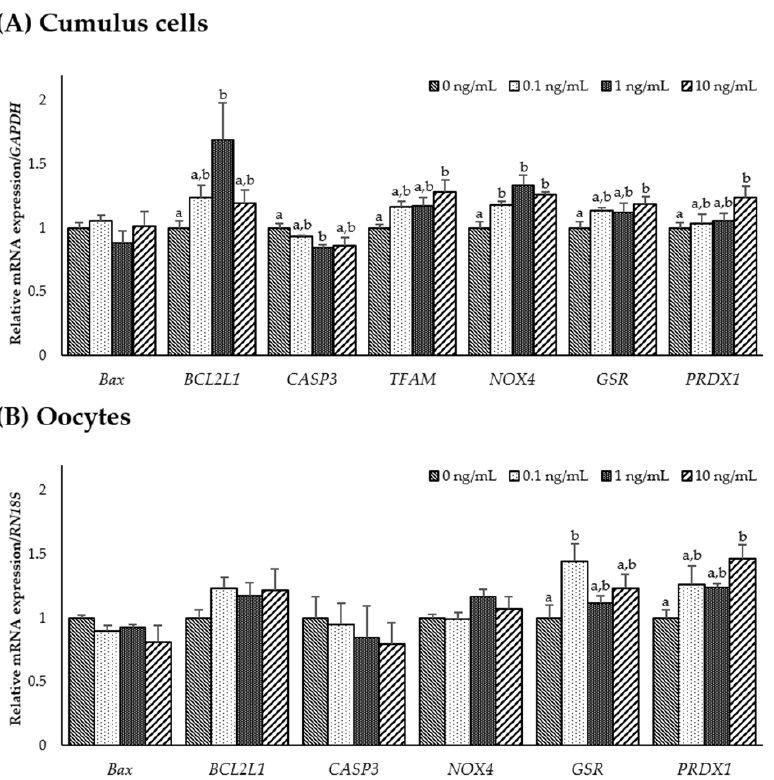
Figure 2. The mRNA expression levels (mean ± SEM) of apoptosis-, mitochondrial-, and antioxi- dant-related genes. Levels of Bax , BCL2L1 , CASP3 , TFAM , NOX4 , GSR1 , and PRDX1 assessed in groups of cumulus cells ( A ) and levels of Bax , BCL2L1 , CASP3 , NOX4 , GSR1 , and PRDX1 assessed in groups of oocytes ( B ) supplemented with various concentrations of interleukin-7 after in vitro maturation. The experiment was replicated three times. The bars with different letters (a, b) are significantly different ( p < 0.05).